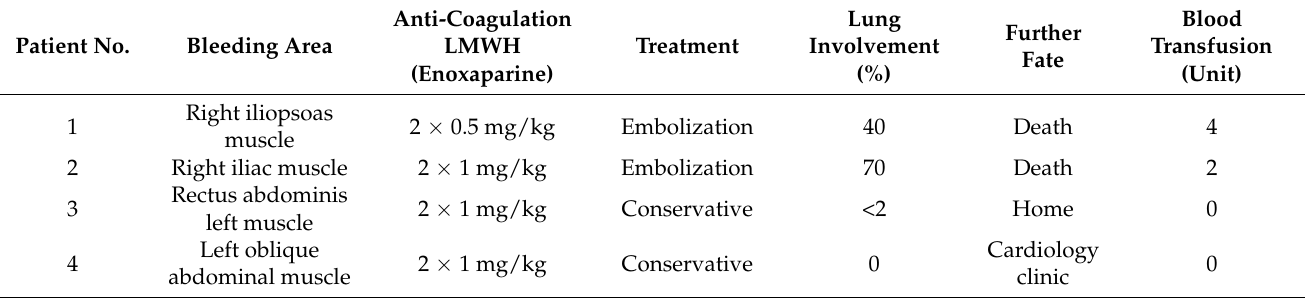
Table 3. Characteristics of patients (anticoagulation during bleeding), site of bleeding, treatment of bleeding, lung involvement, and further fate of